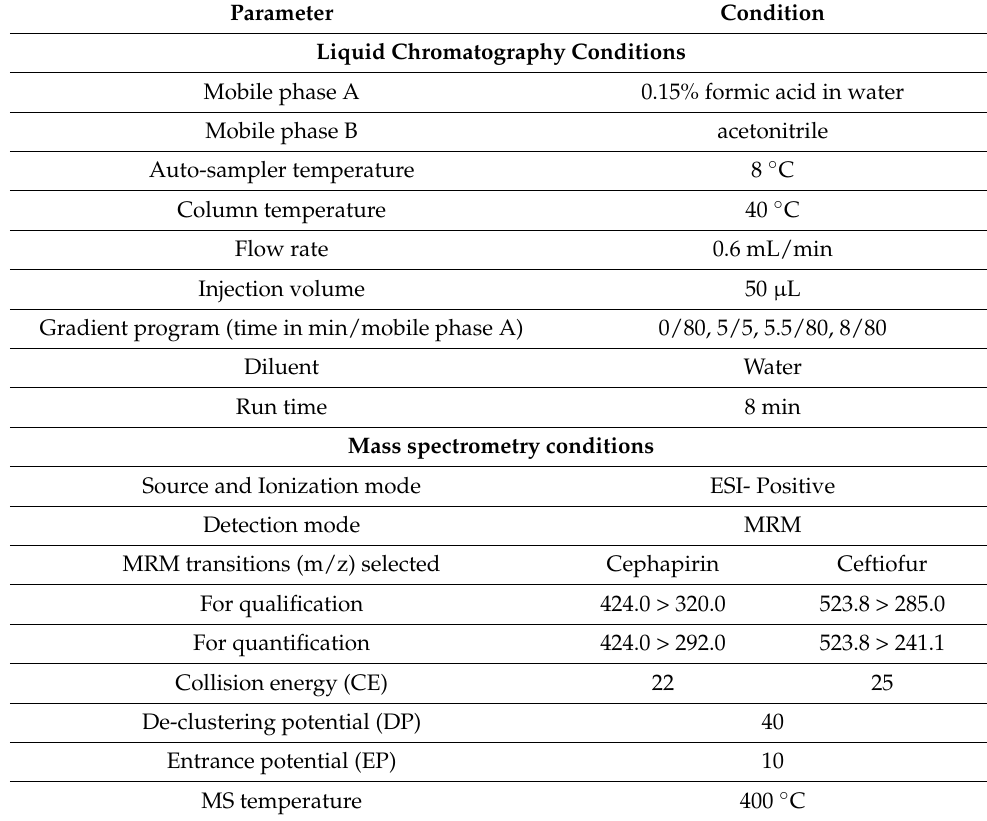
Table 3. Liquid chromatographic and mass spectrometric method